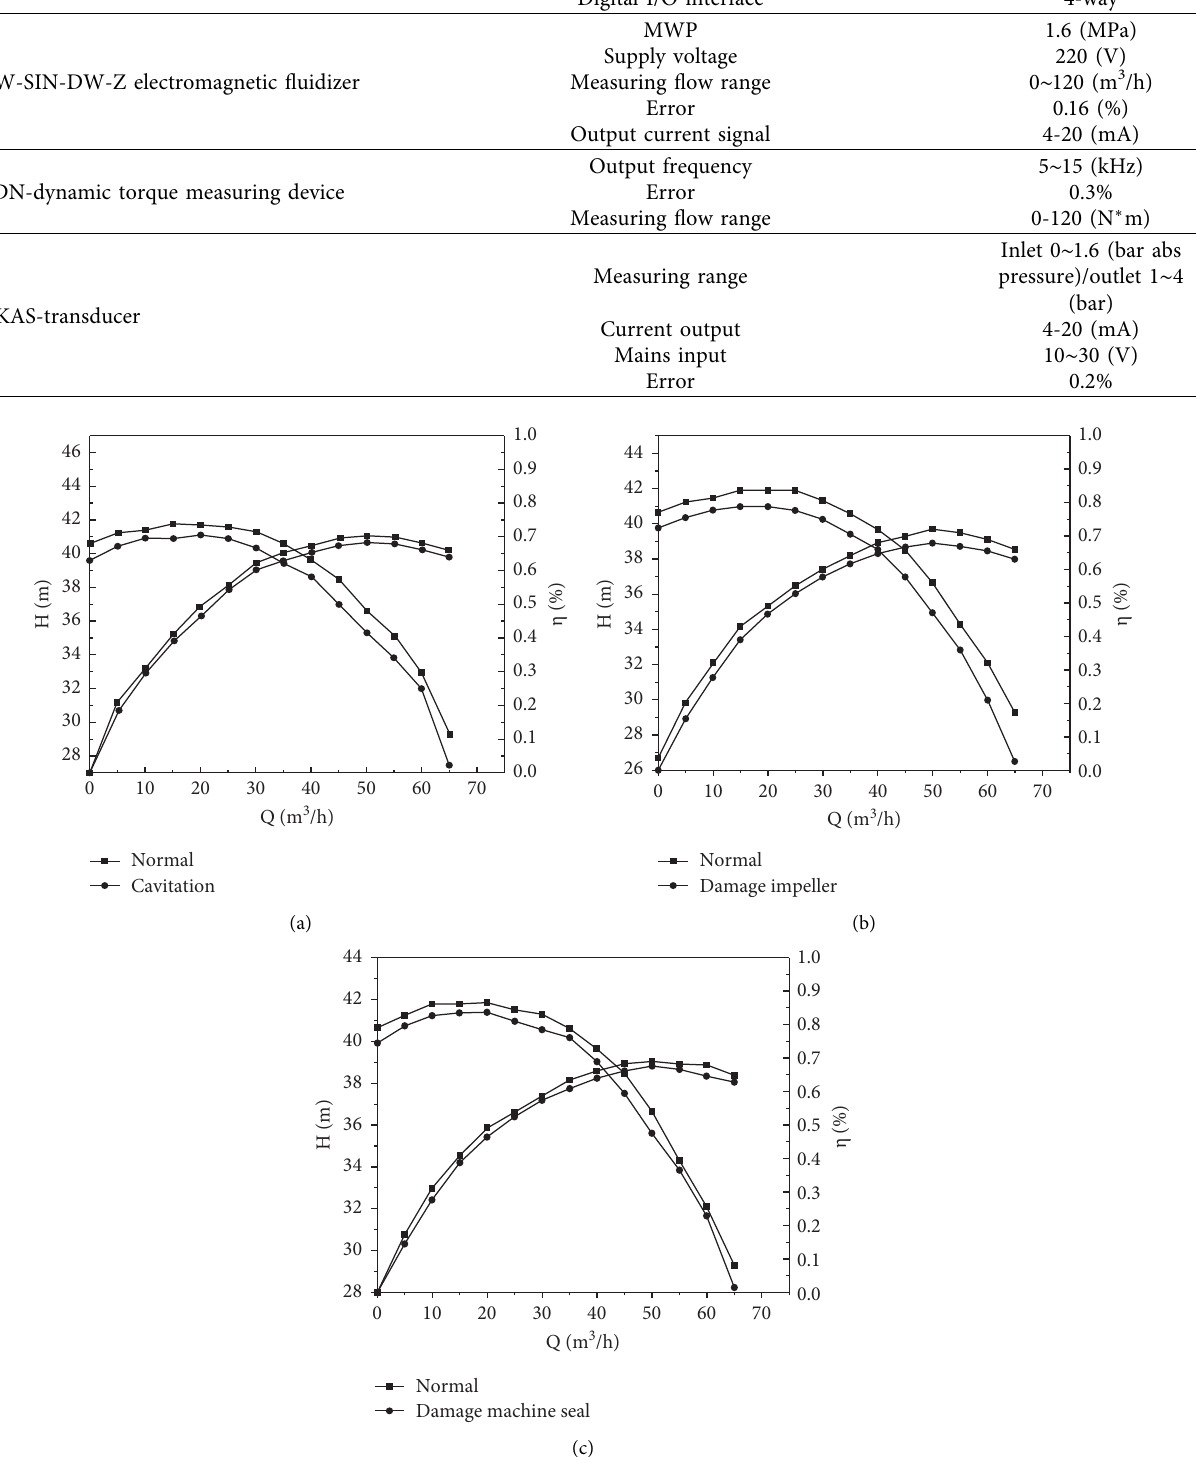
Figure 7: (a) External characteristics of cavitation and normal working conditions. (b) External characteristics of damage impeller and normal working conditions. (c) External characteristics of damage machine seal and normal working